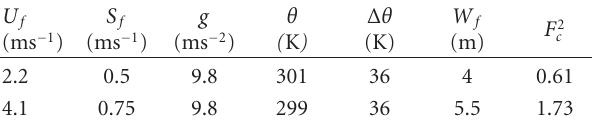
Table 1: Numbers used to calculate the convective Froude number in two cases: up-valley wind case (1st row) and sea breeze wind case (2nd row). U f represents ambient wind speed, U f forward rate of fire spread, g gravity, θ potential temperature, Δ θ mean perturbation temperature near the region of intense heating, W f fire line depth, and F c convective Froude